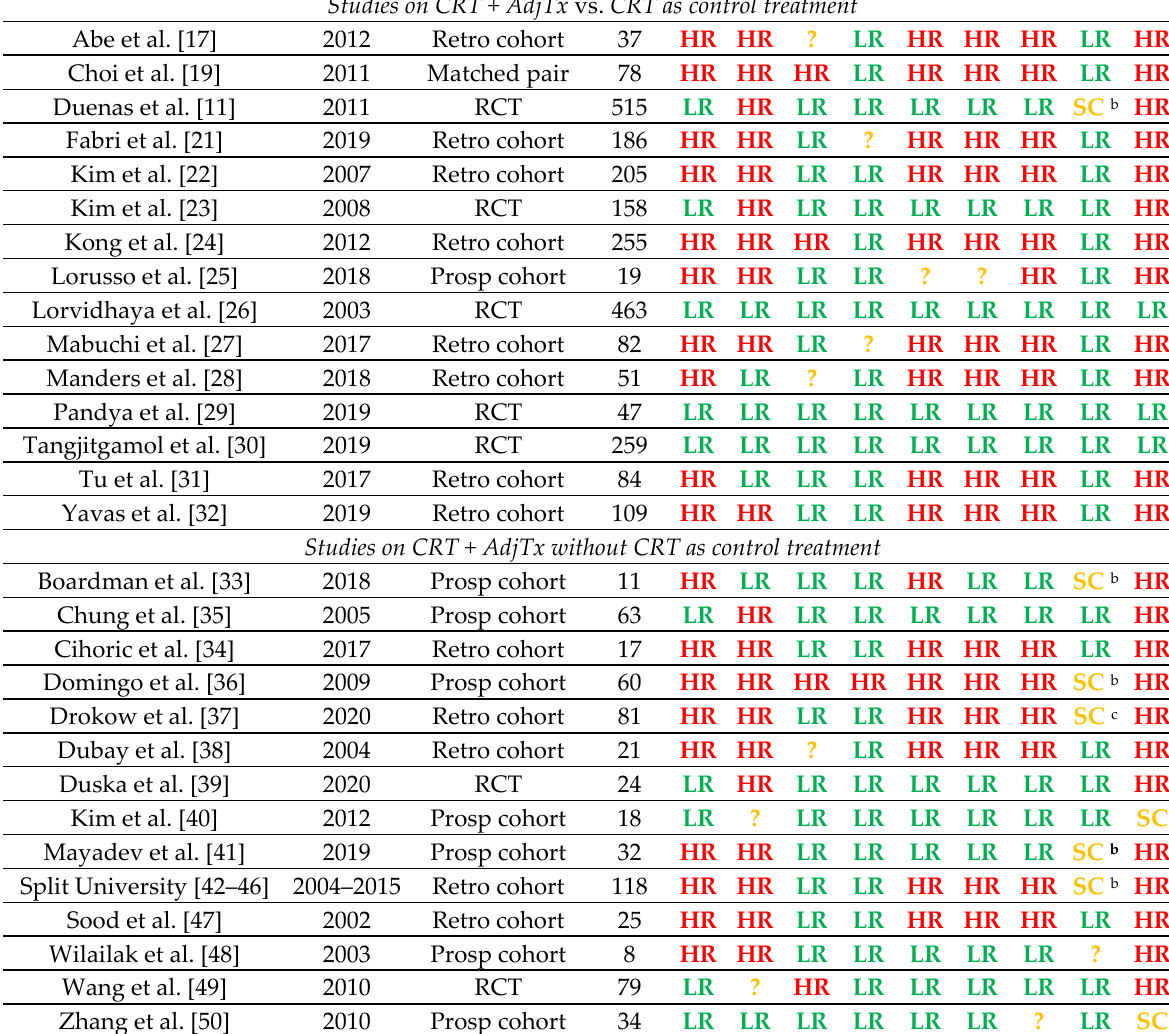
Figure 2. Risk of bias assessment of included studies. Definition of abbreviations: CRT = chemoradiotherapy; AdjTx = adju- vant systemic therapy; RCT = randomized controlled trial; Pros = prospective study; Retro = retrospective study; HR = high risk; LR = low risk; SC = some concerns; ? = unclear risk. a The number of patients reported in this table are the numbers of patients that could be included in the current study as either a control group (CRT) or experimental group (CRT + AdjTx); patients who were treated with other regimens (e.g., radiotherapy only) are not included in the current study and not represented here. b Conflicts of interest of one or more authors; relations with or employees of pharmaceutical companies. c Concerns about correctness of reported survival outcomes; discrepancies between reported estimates and survival